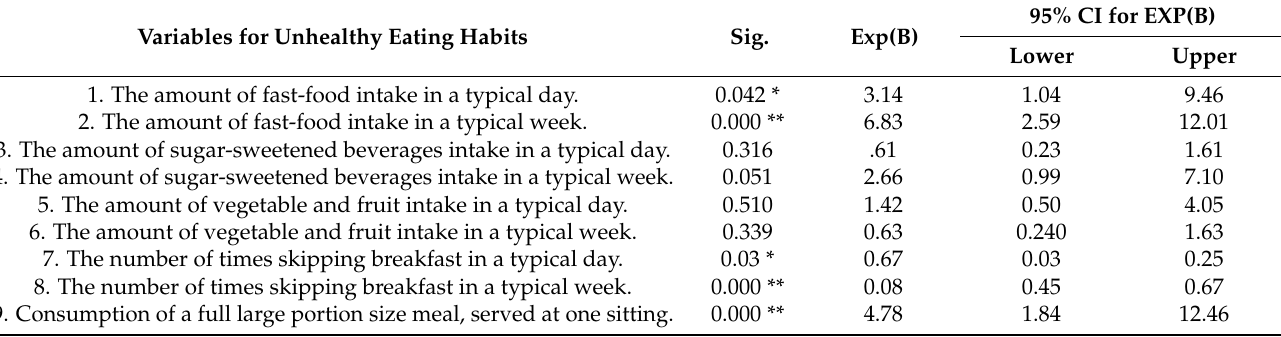
Table 4. The impact of multiple independent variables (unhealthy eating habits) on obesity among Libyan adults of both genders using binary logistic regression.